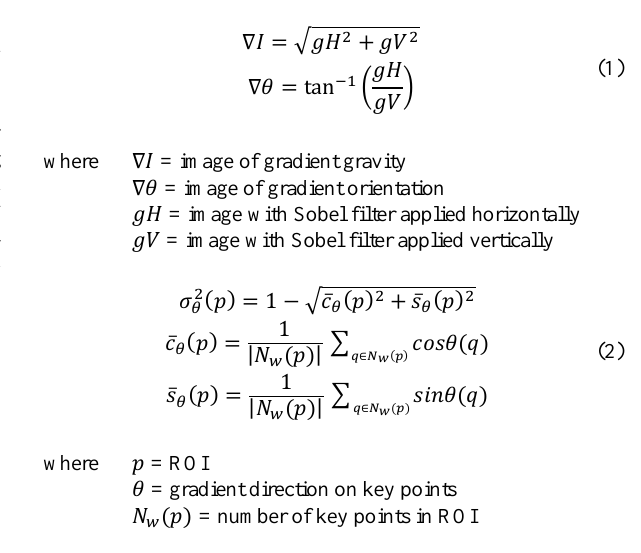
Figure 2. Blur in aerial photographs (Left: clear image, Right: blurry image)